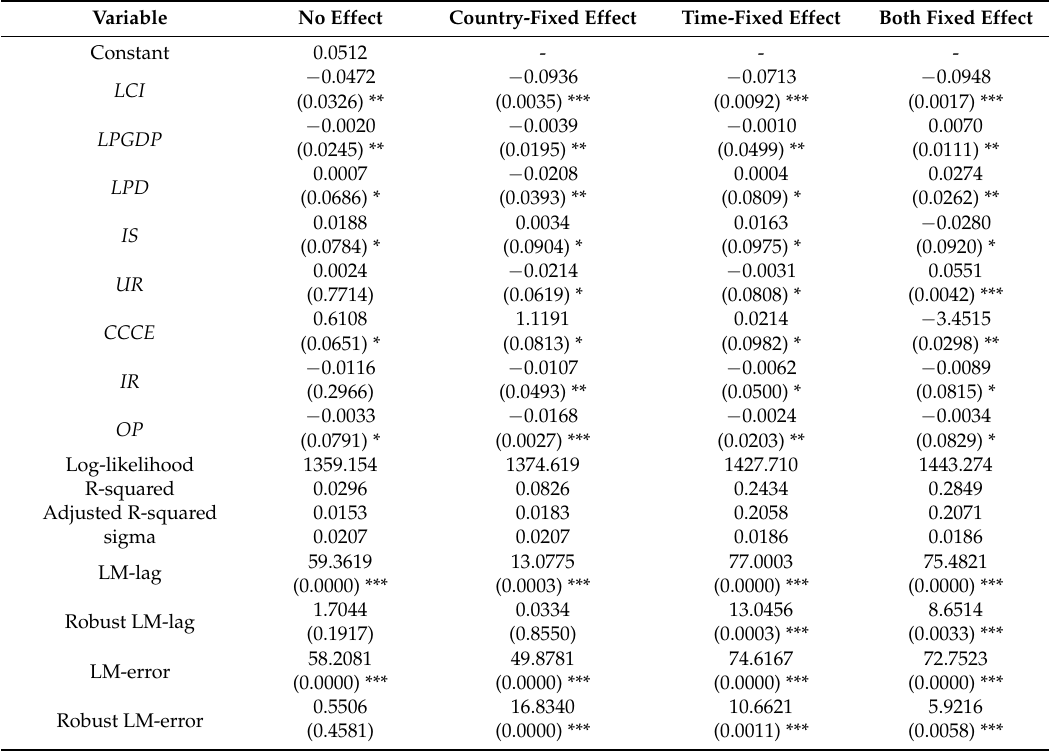
Table 9. OLS estimation and test results of conditional convergence of carbon intensity ( p -values in parentheses).